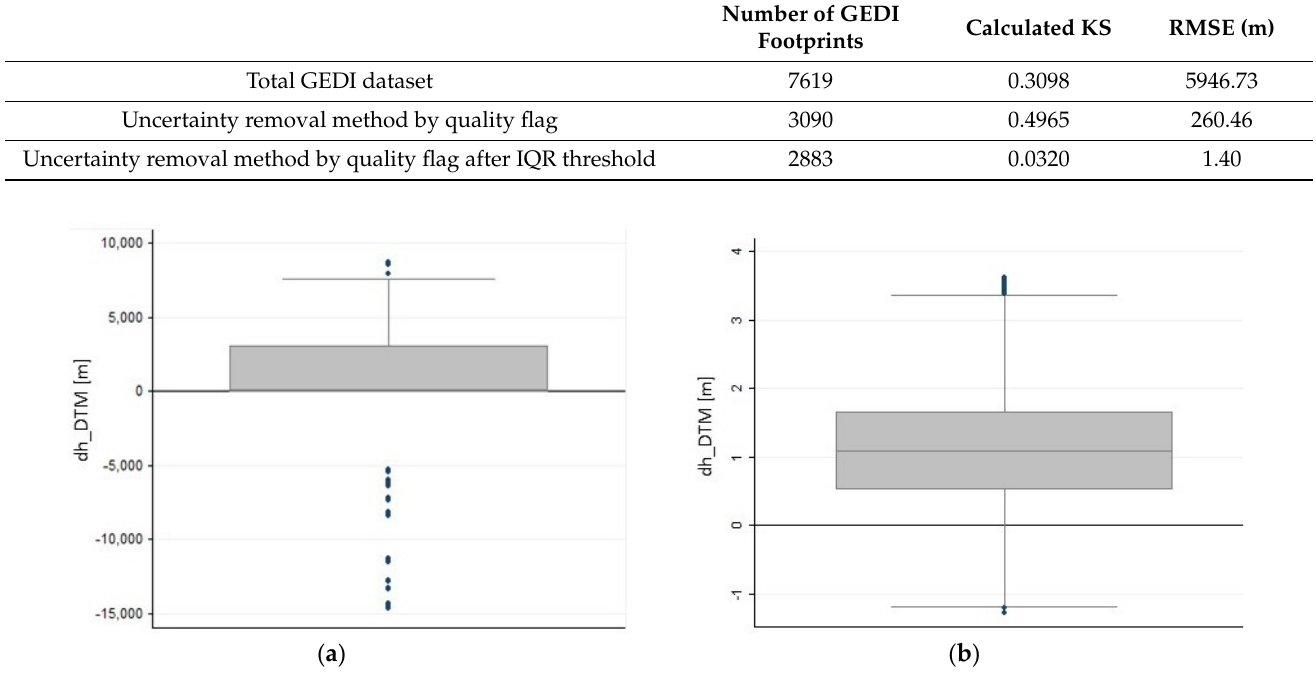
Figure 9. Boxplots showing the distribution of dh-DTM of the total GEDI dataset. ( a ) Original distribution of dh-DTM; ( b ) resulted distribution of dh-DTM after applying a second step based on IQR thresholds. Table 4. Statistics from the dh-DTM quality flag to remove uncertainties and its IQR threshold im- provement.